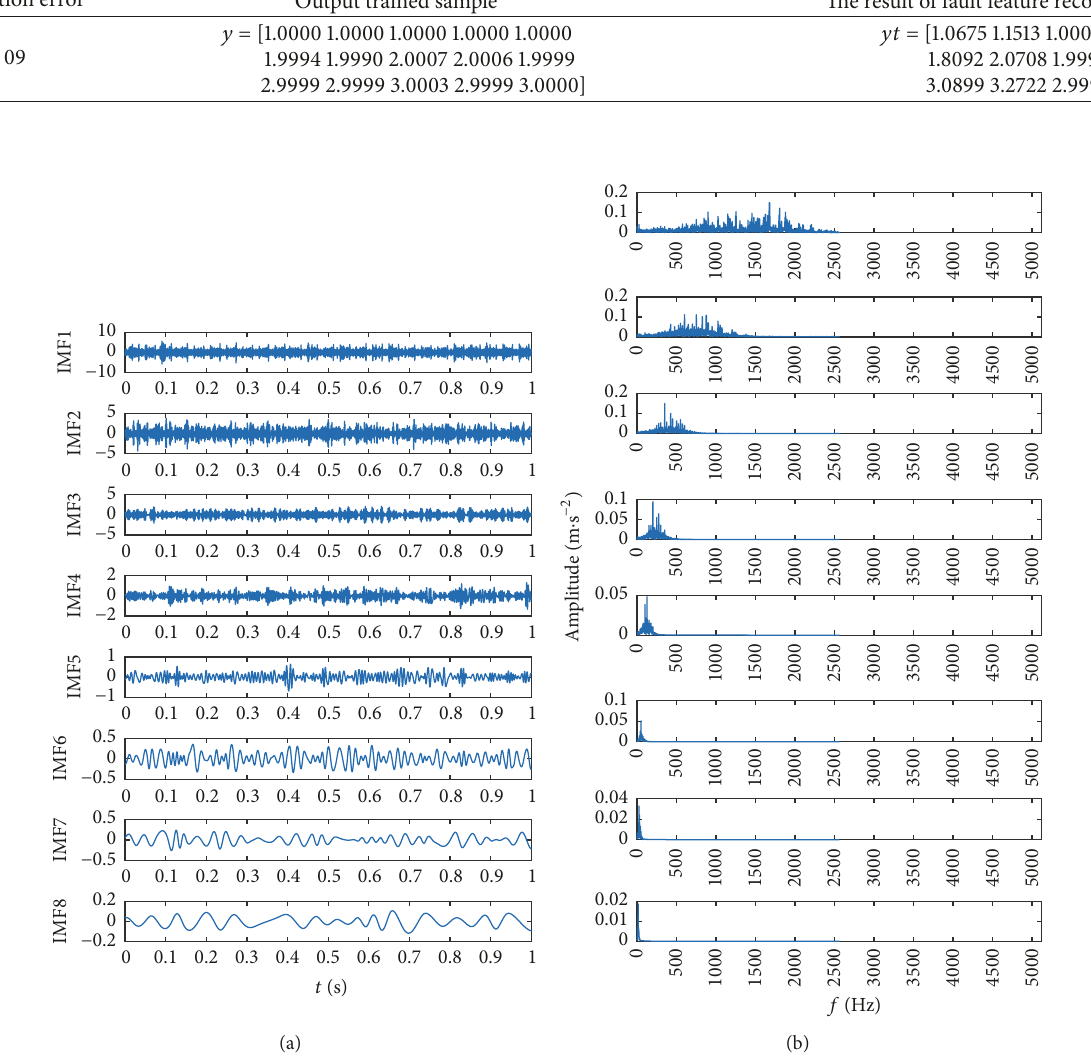
Figure 4: The first 8 IMFS and their frequency-domain diagrams after EMD of crankshaft bearing vibration signal in normal